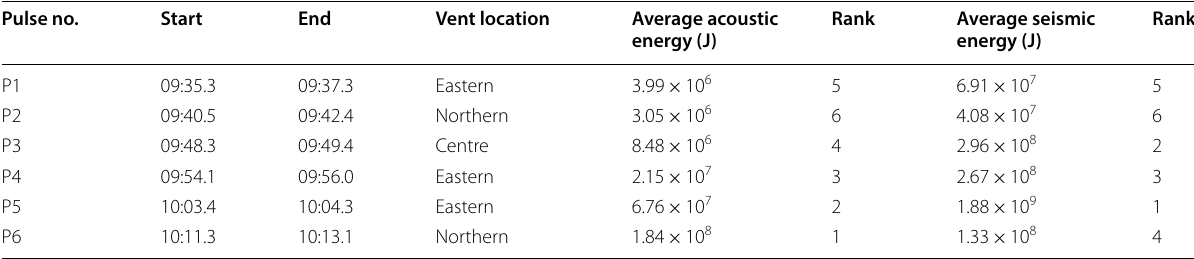
Acoustic average from stations WIZ and WSRZ. Seismic energy average from permanent and temporary seismic stations WIZ, WSRZ, WI01, WI02, WI04, WI13 (Walsh et al. 2019)